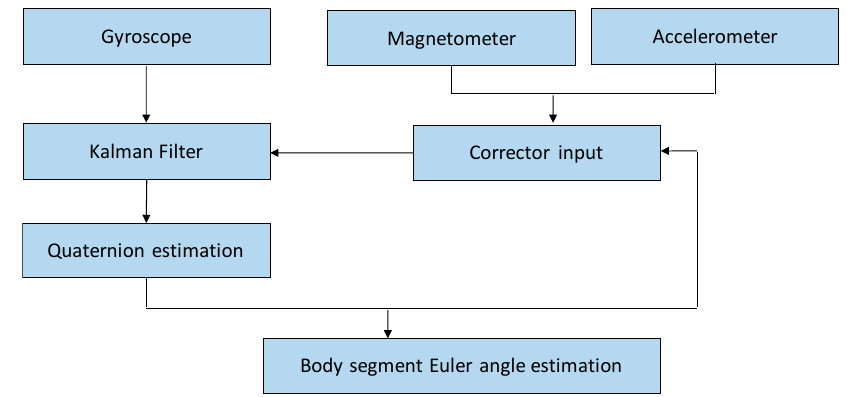
Figure 5. Estimation of the Euler angle of a human segment.